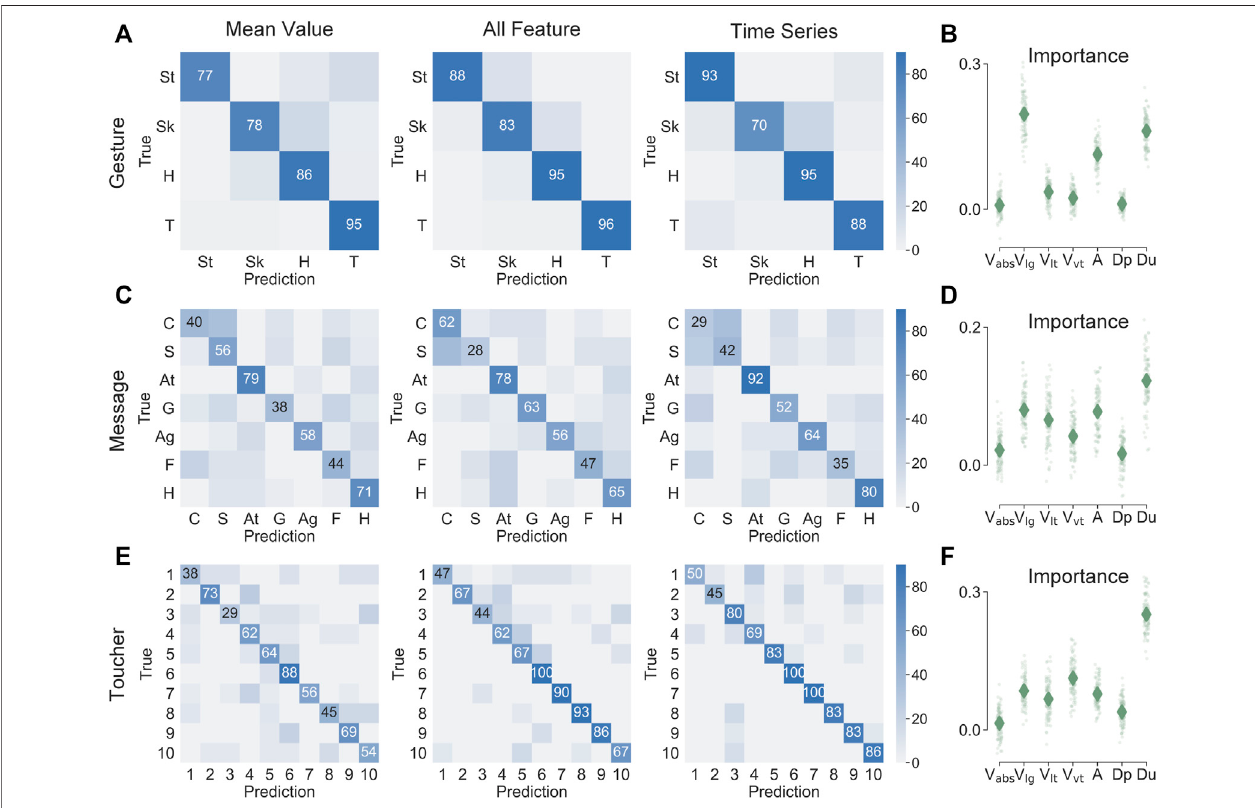
FIGURE 5 | Classi fi cation of touch gestures, delivered messages, and toucher individuals using the mean value, all relevant features, and time-series data of contact attributes, respectively.The accuracy in prediction of (A) touch gestures, (C) delivered messages, (E) toucher individual are shown, aswell as the importance of particular contact attributes in classifying (B) touch gestures, (D) delivered messages, (F) toucher individual. Numbers and colors in confusion matrices represent the prediction percentage. In the importance plots, the diamonds denote means; points denote importance values from 100 repetitions of classi fi cation.